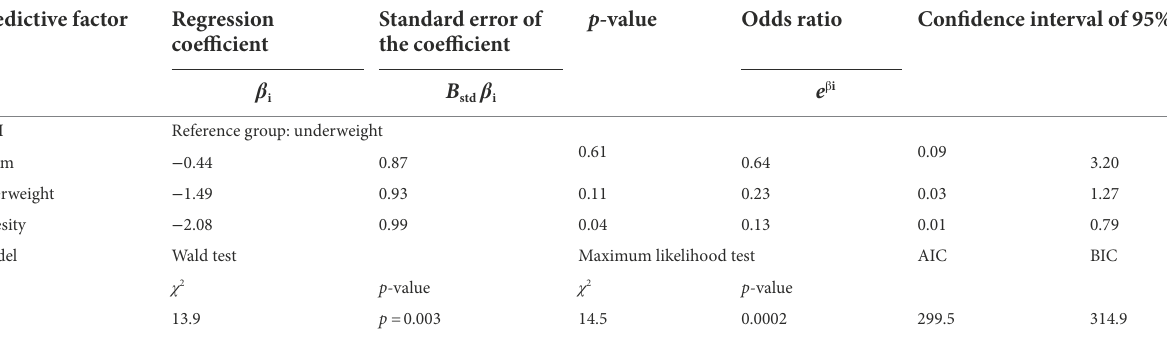
TABLE 6 Estimation of the ordered logistic regression model parameters for the identification of sweetness (0.1.2) depending on BioData. frequency of fermented milk product consumption, and yogurt preferences. Predictive factor